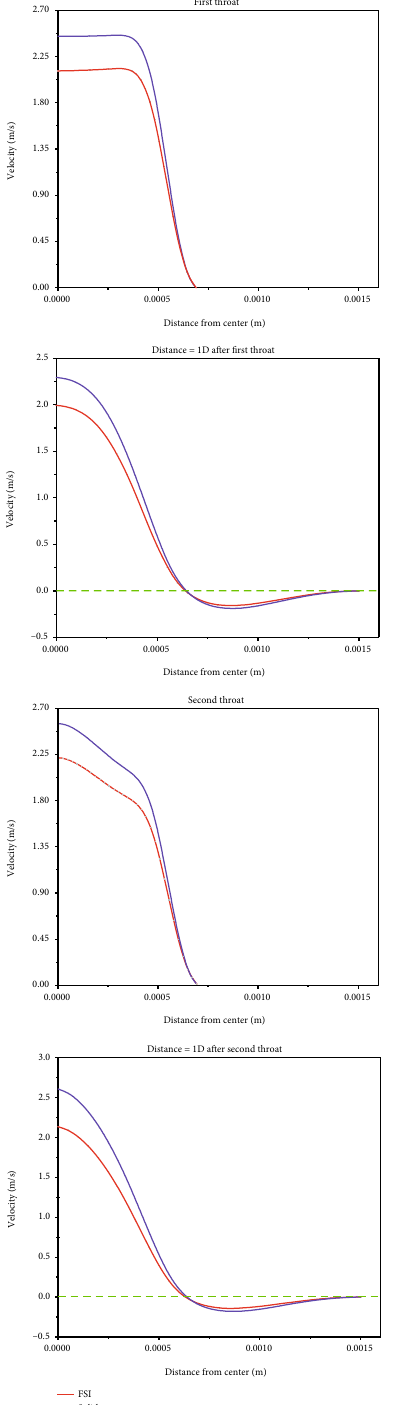
Figure 9: Comparing hemodynamic parameters between the rigid and elastic walls for simple and double stenosis.